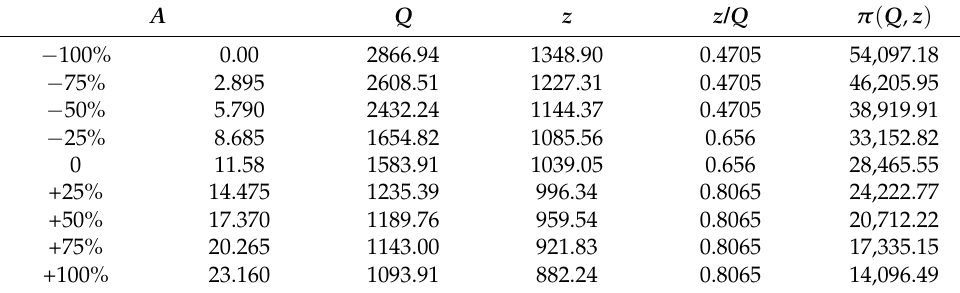
Table 3. The result for various unit acquisition costs A